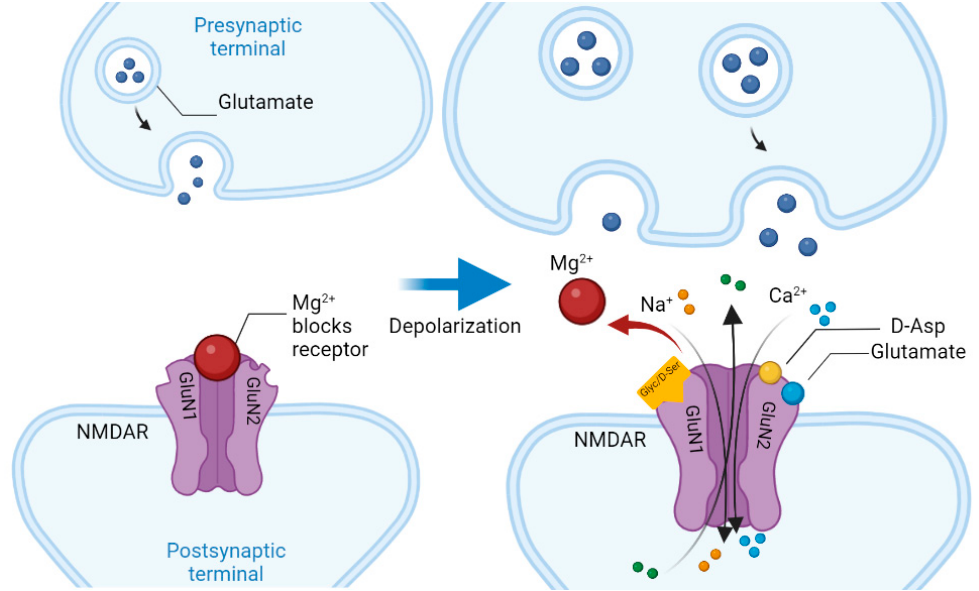
Figure 3. Scheme of the N -methyl-D-aspartate receptor (NMDR) functioning. Note: D-Asp—D-as- partate; D-Ser—D-serine; Glyc—glycine.